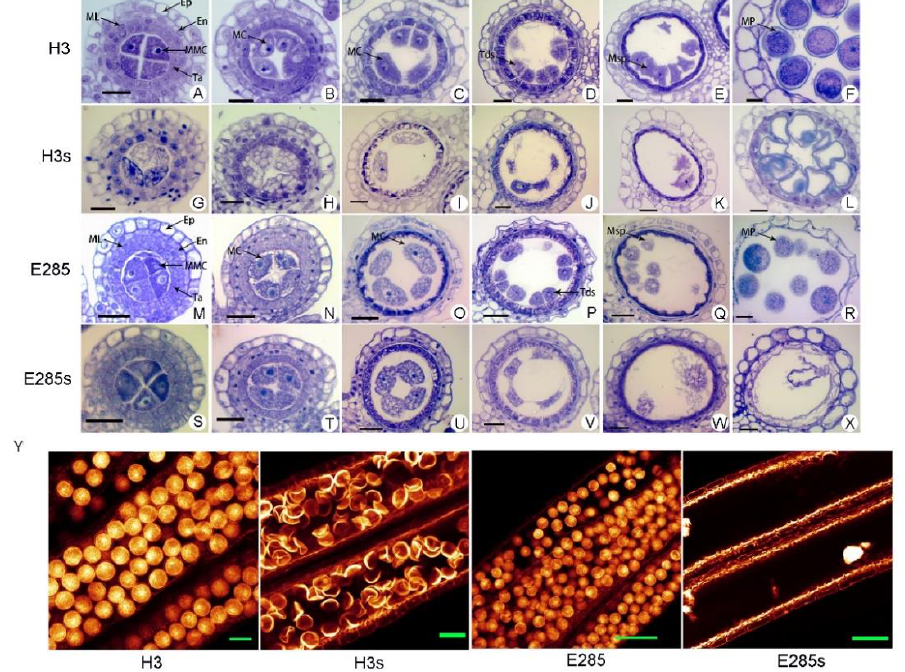
Figure 3. Comparison of transverse sections of the anthers of wild-type and TMS5 mutants, H3s and E285s, grown at high temperature. ( A – F ) and ( M – R ) semi-thin sections of wild type anthers, ( G – L ) and ( S – X ) semi-thin sections of TMS5 mutant anthers. ( A , G , M , S ) Microspore mother cell formation stage; ( B , H , N , T , C , I , O , U ) meiosis stage I; ( D , J , P , V ) tetrad stage; ( E , K , Q , W ) single microspore stage; ( F , L , R , X ) mature pollen stage. Ep, epidermis; En, endothecium; Ta, tapetum; MMC, microspore mother cell; MC, meiotic cell; Tds, tetrads; Msp, microspore parietal cell; MP, mature pollen. ( Y ) Anthers and mature pollen grains between the wild type and TMS5 mutant using WE-CLSM analysis. Bars = 50 μm.